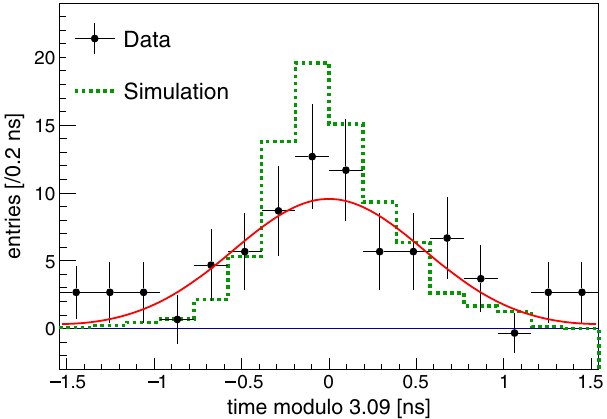
FIG. 12. Bunch width measurement results. The black data points with error bars indicate the data including background subtraction based on the pulse-height cuts. The broken line indicates the simulated value. The solid line is a result of Gaussian fitting. The event number in the simulation was normalized to the experimental data. The range of the horizontal axis corresponds to a period of the operating